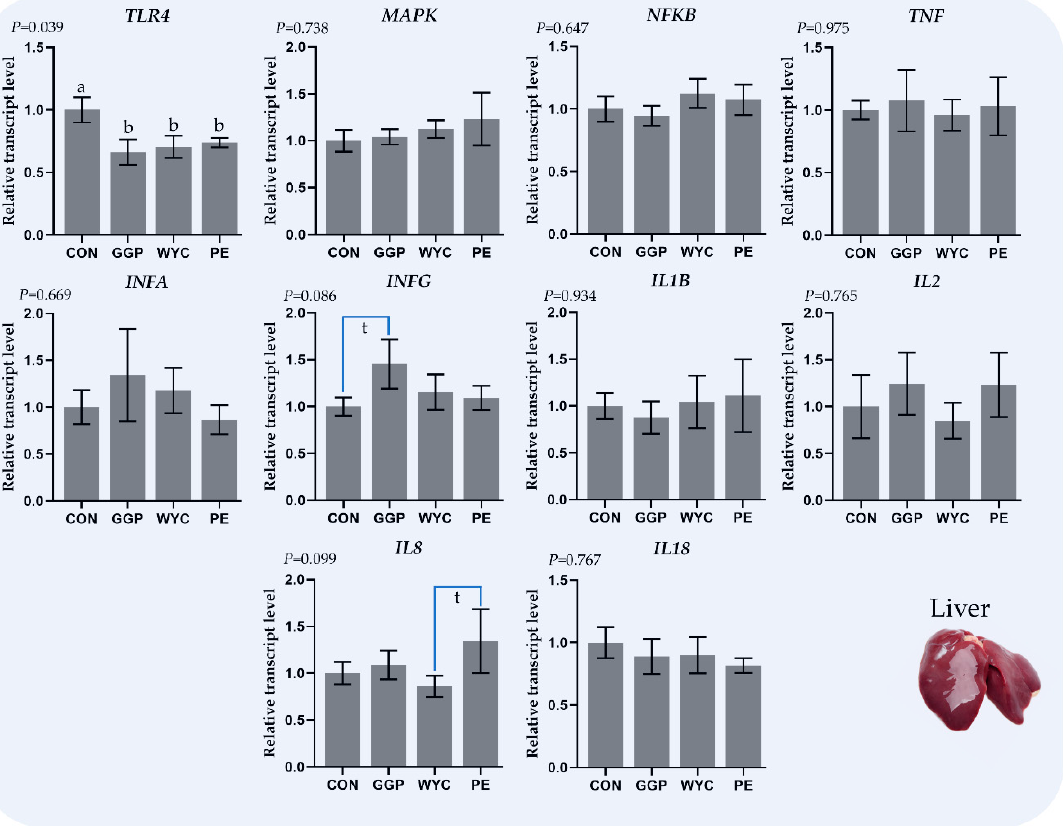
Figure 1. Relative transcript levels (means ± SEM) of immune-related genes in the liver of 42-day-old broilers. Bars with different letter (a, b) amongst the treatments differ significantly ( p ≤ 0.05) while t represents 0.05 < p -value < 0.10.